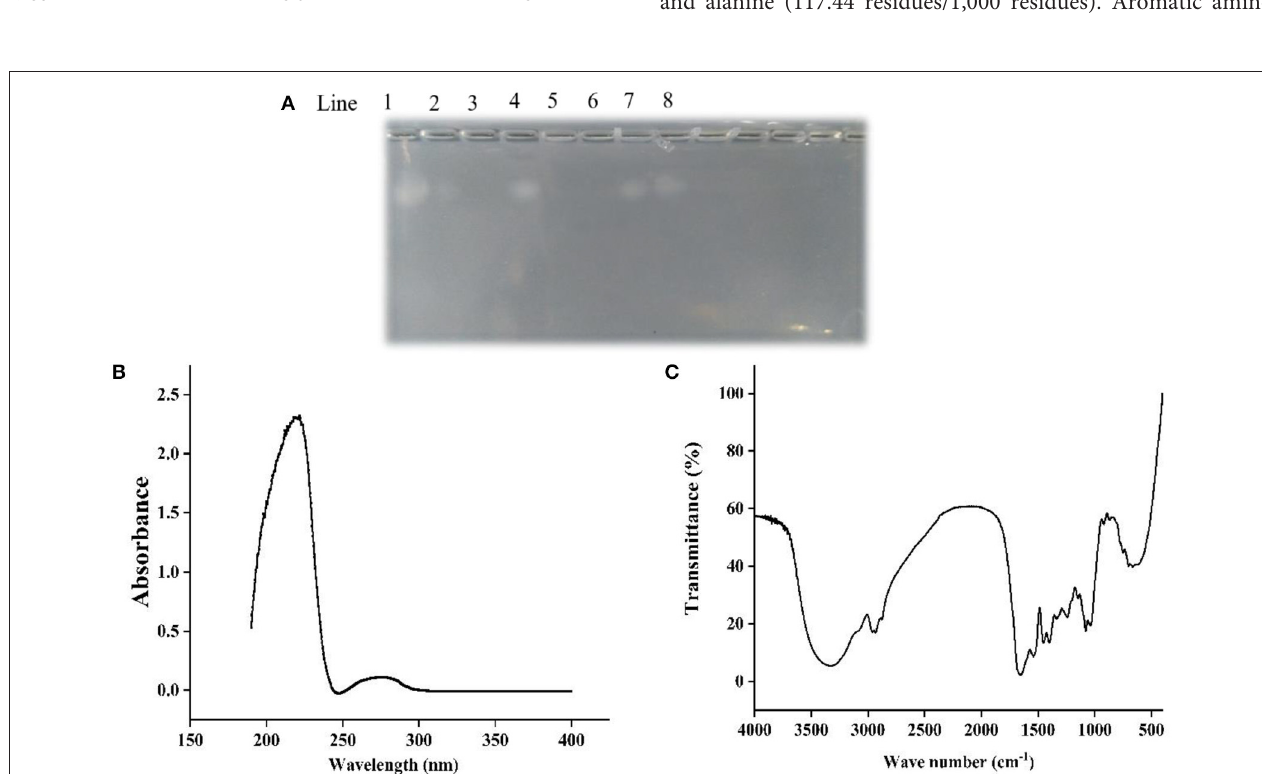
FIGURE 1 | Agarose-gel electrophoresis (A) , UV (B) , and FT-IR (C) of Echondroitin sulfate. Line 1 was chondroitin sulfate standard, line 2 and 3 were 75 and 85% ethanol extracts of double enzyme hydrolysate, line 4 and 5 were 75 and 85% ethanol extracts of papain hydrolysate, line 6 and 7 were < 10 kDa and more than 10 kDa components of double enzyme hydrolysate, and line 8 were 85% ethanol precipitation components of double enzyme hydrolysate.